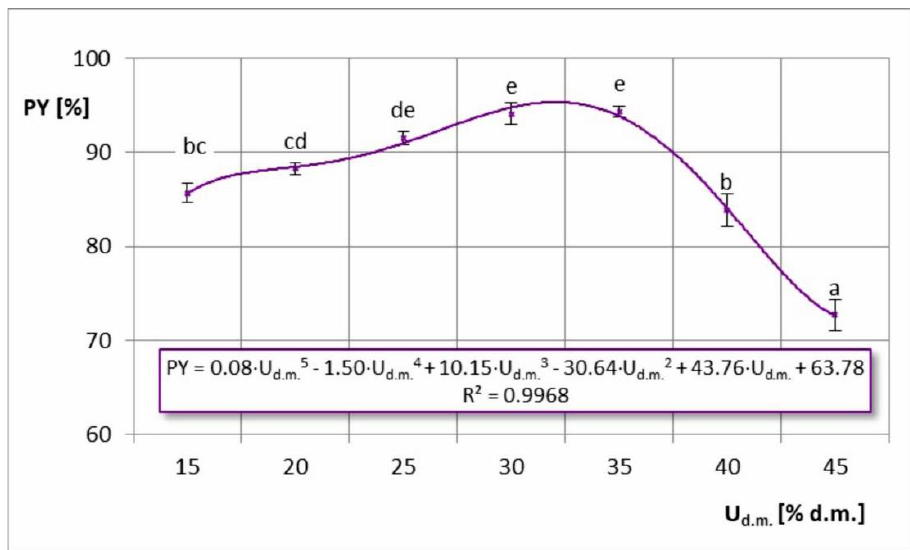
Figure 4. Powder yield (PY) in the process of spray drying chokeberry juice with different dry matter content in the feed solution (U d.m. ); (a, b, c, d, e — different letters show significant differences between mean values ( p ≤ 0.05)).